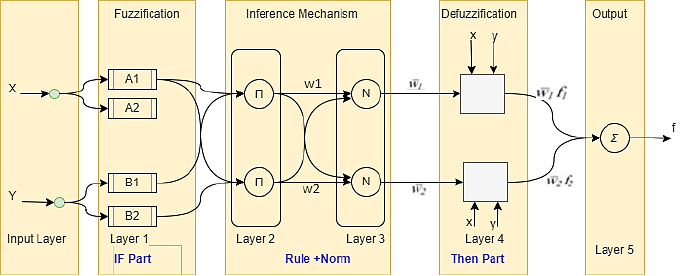
Fig. 2. Structure of ANFIS algorithm